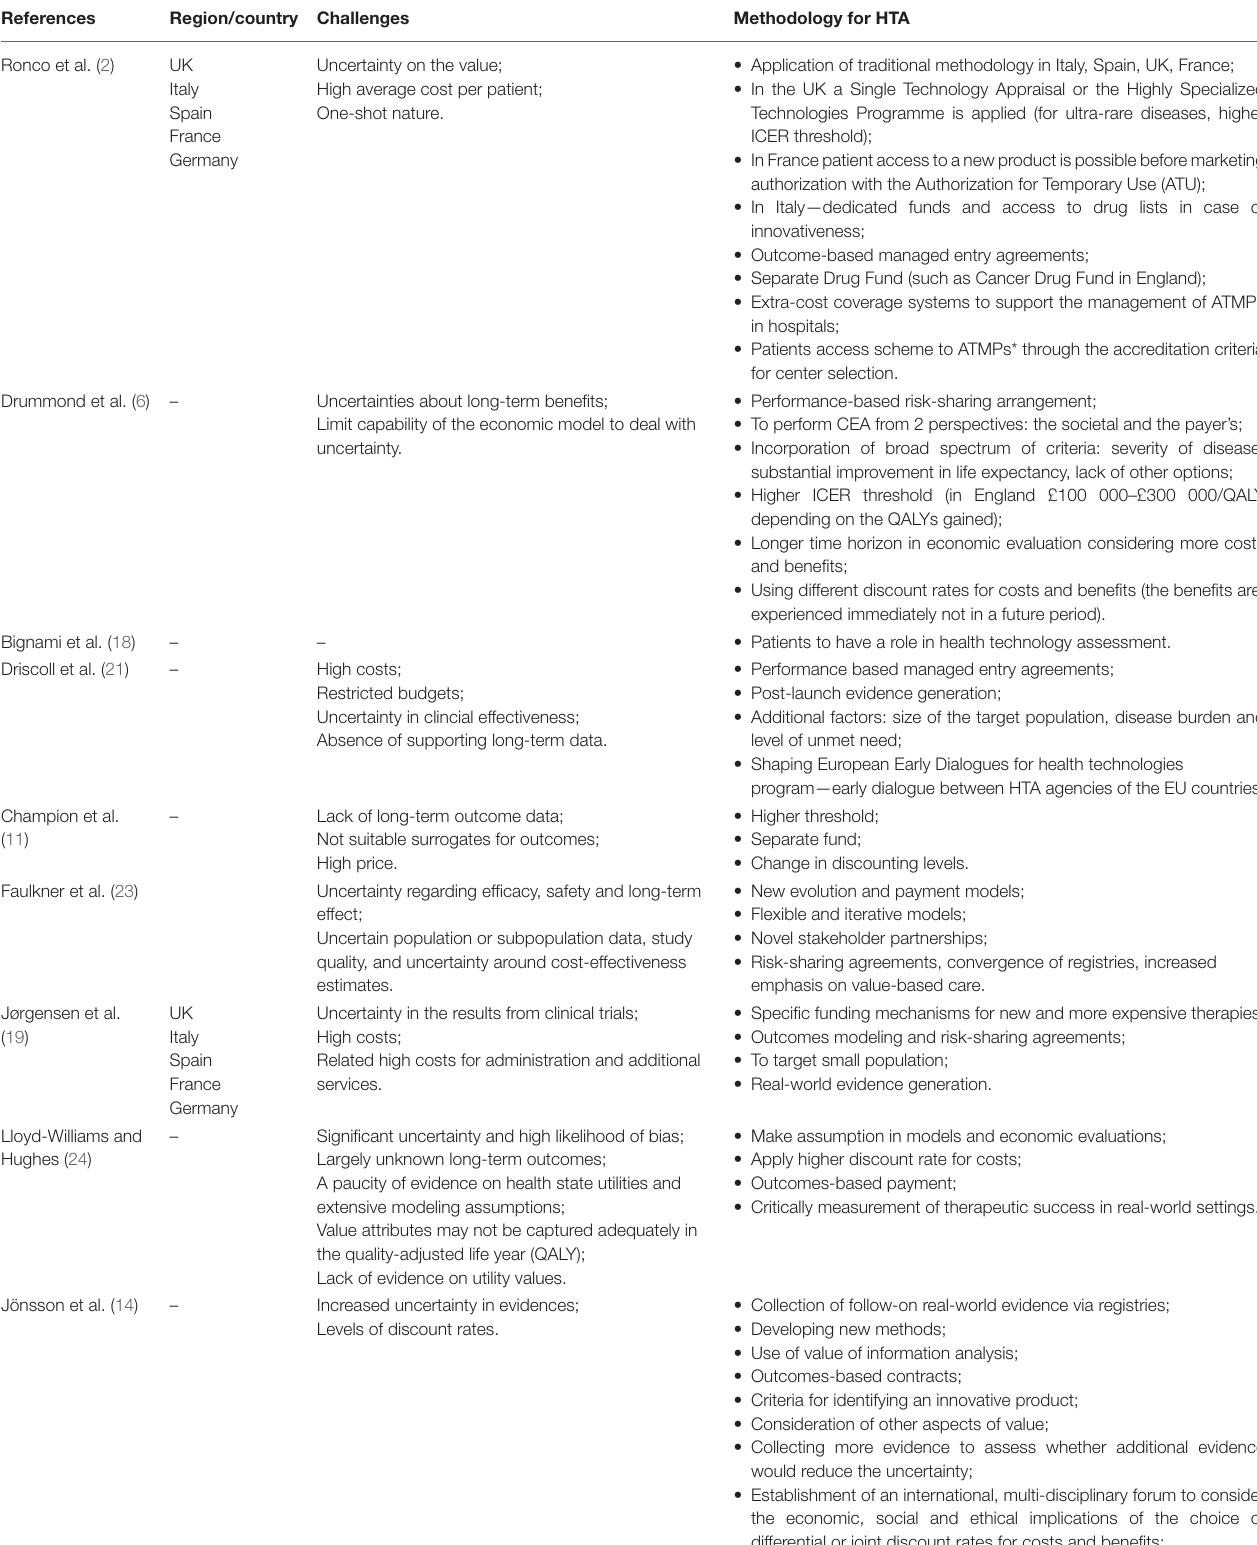
TABLE 1 | Recommendations for HTA of advanced therapies—a literature review